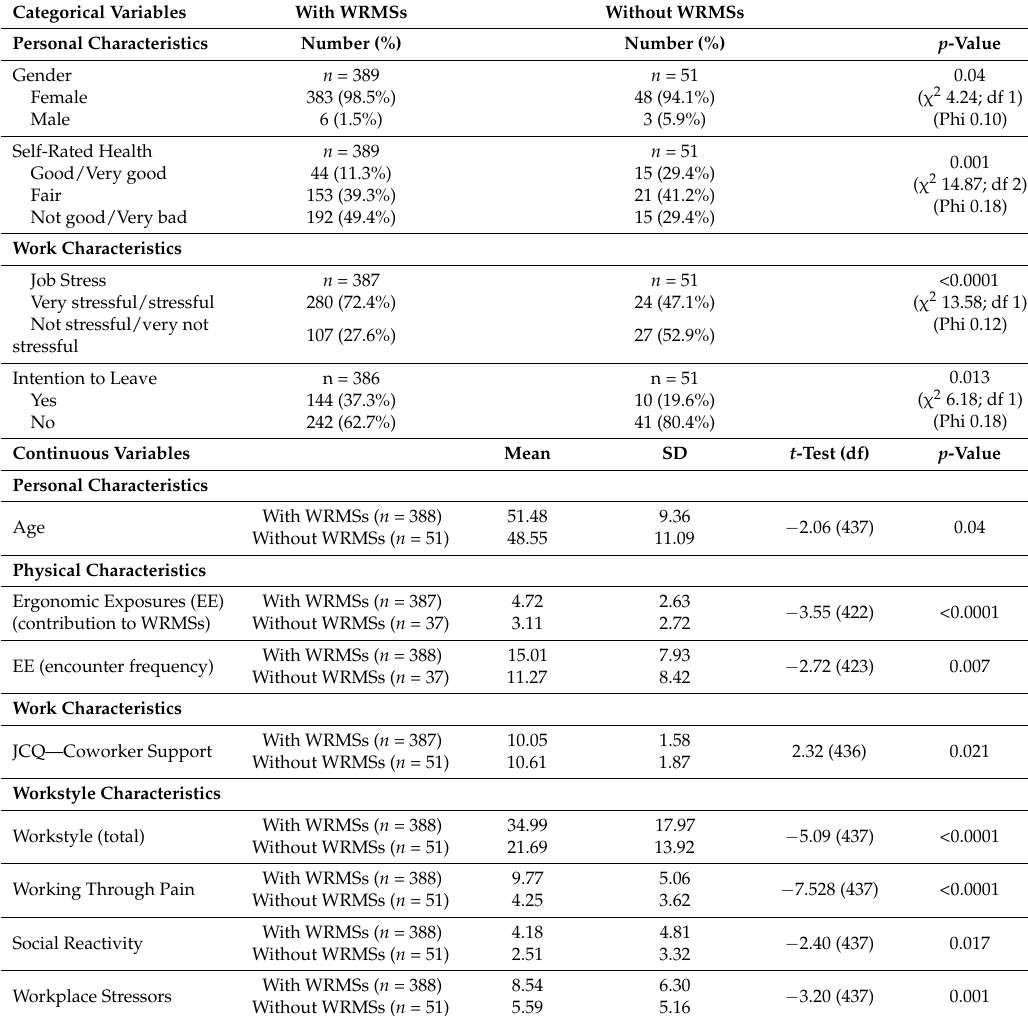
Table 3. Factors significantly associated with WRMSs among NAs measured at the time of survey: A bivariate analysis (N =